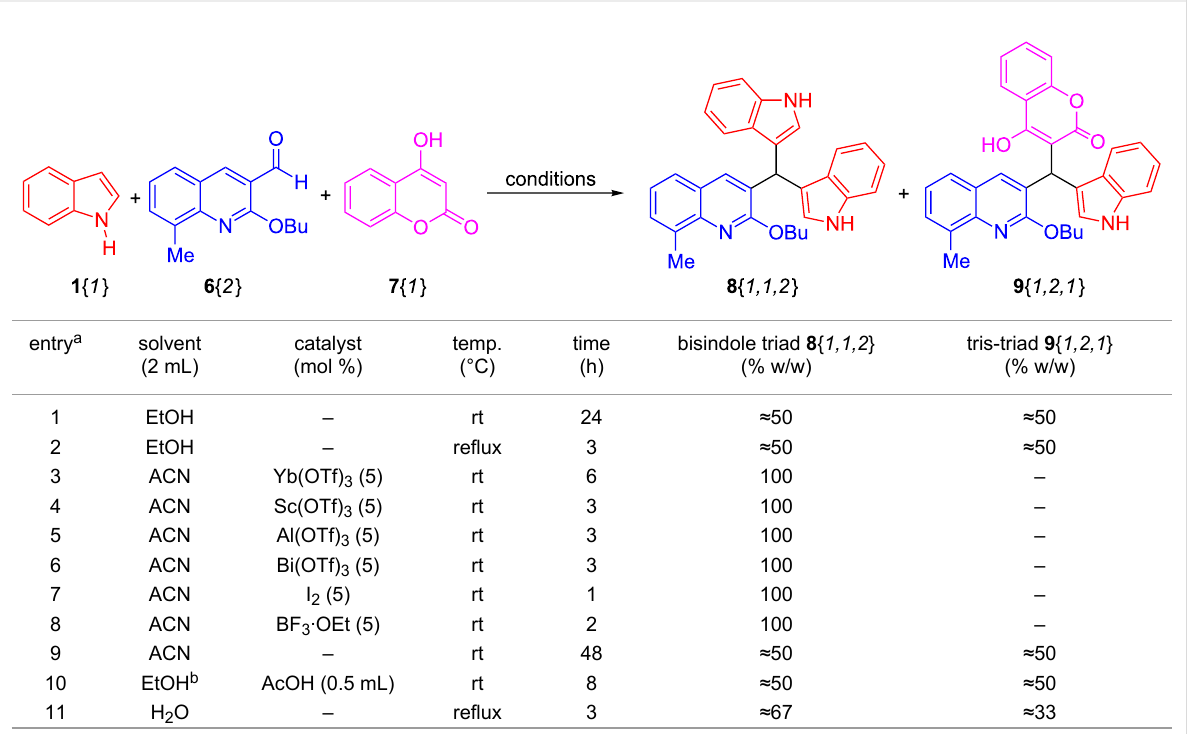
Table 1: Optimization of the reaction conditions for the three-component synthesis of triads 8 { 1,1,2 } and 9 { 1,2,1